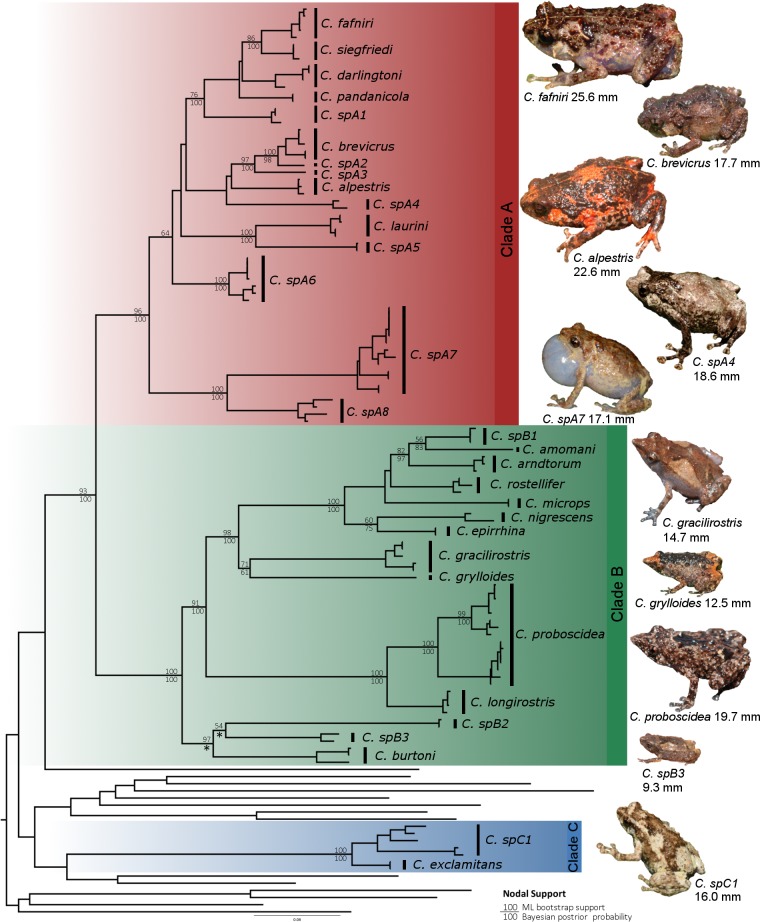
Maximum likelihood tree of Choerophryne.* indicates <50% Bayesian posterior probability, interspecific nodes without support values were poorly resolved in both analyses, intraspecific node supports are omitted for clarity. All photographs by S Richards.